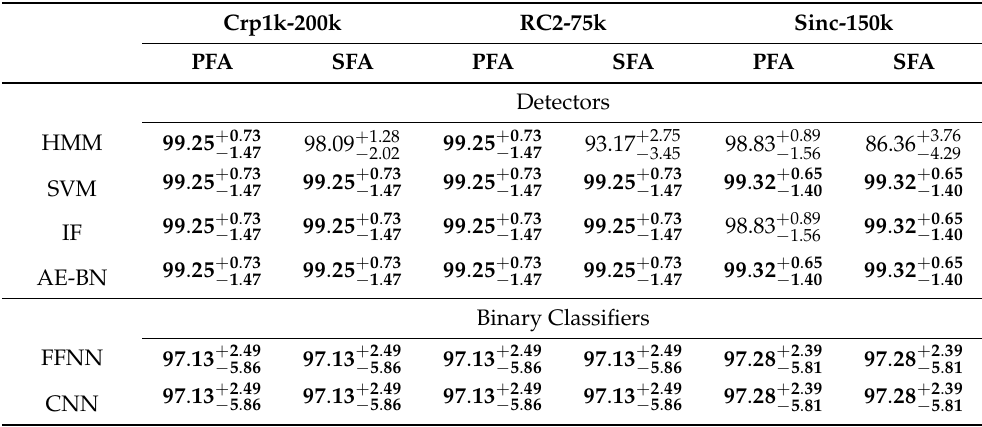
Table 5. BAR (in percent) along with 95% CI of classifiers depending on feature sets and datasets. For each case of classifiers, the best performing ones with respect to excitation signals and used features are denoted in boldface.